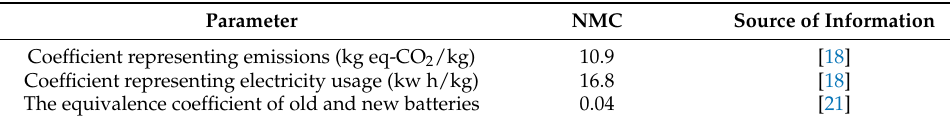
Table 6. Data used for the battery manufacturing process.